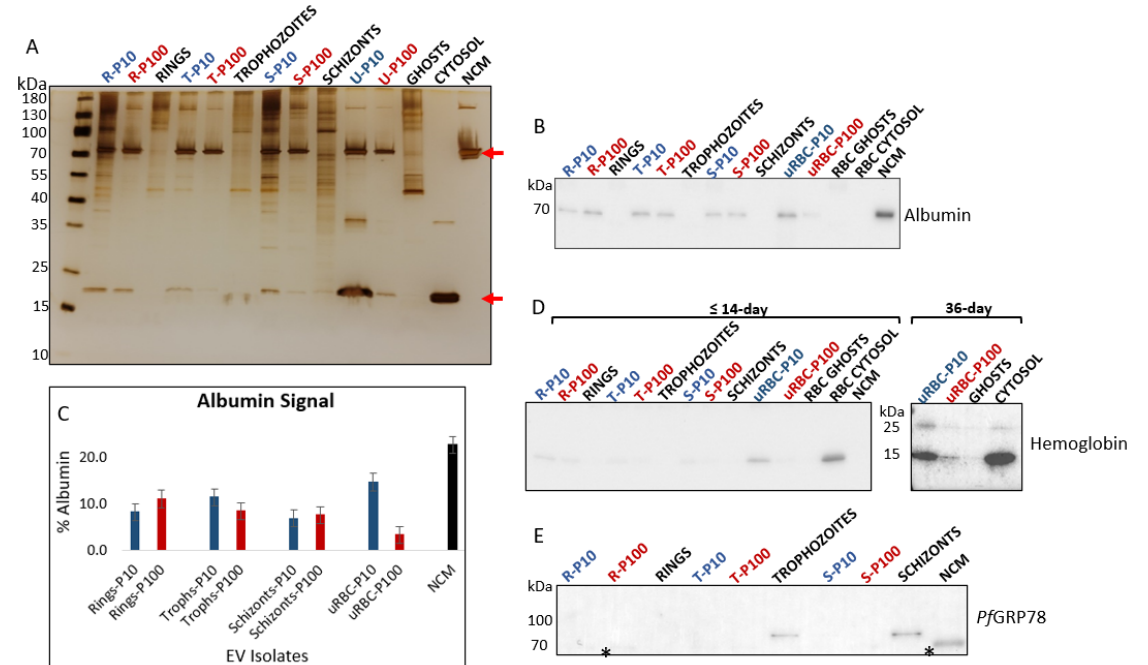
Figure 6. ( A ) SDS-PAGE and silver staining of EVs and cell lysates revealed distinct protein separation profiles. Top red arrow is albumin (70 kDa), and bottom red arrow is hemoglobin (16 kDa). ( B ) Immunoblot of albumin. Albumin present in culture medium co-isolates with EVs. NCM was in- cluded as a control to assess the extent of albumin depletion from EV isolates. No albumin was present in cell lysates. ( C ) Densitometric analysis of albumin in EV isolates. ( D ) Hemoglobin is more abundant in EVs of aging RBCs and almost undetectable in the iRBC EVs from pooled cultures of RBCs ≤14 days. Immunoblot shows an increase in hemoglobin content from ≤14 -day to 36-day old RBCs. ( E ) Pf GRP78 (78 kDa) is absent from all malaria derived EVs and can only be seen in tropho- zoite and schizont lysates. Anti- Pf GRP78 cross-reacts with albumin in samples (lower band, marked with asterisk). P10 EVs–blue, P100 EVs–red, cell lysates and controls–black. R–rings, T–trophozoites, S–schi- zonts, uRBC–uninfected RBCs, NCM–non-conditioned media